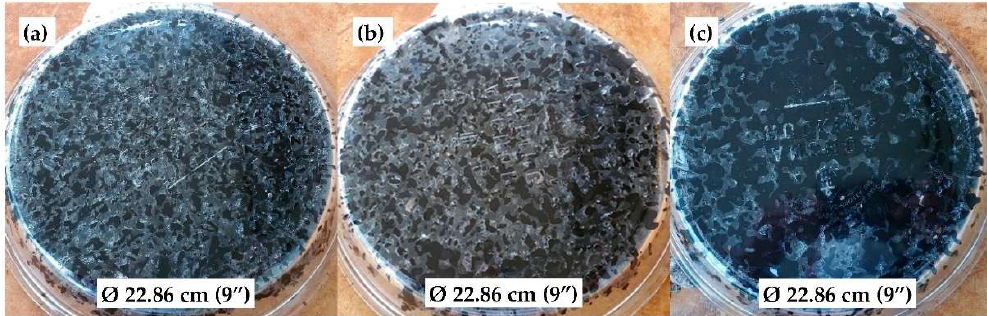
Figure 5. Samples used to determine the OBC using the pie plate method [31]: ( a ) 5.5% binder content; ( b ) 6.0% binder content; and ( c ) 6.5% binder content.